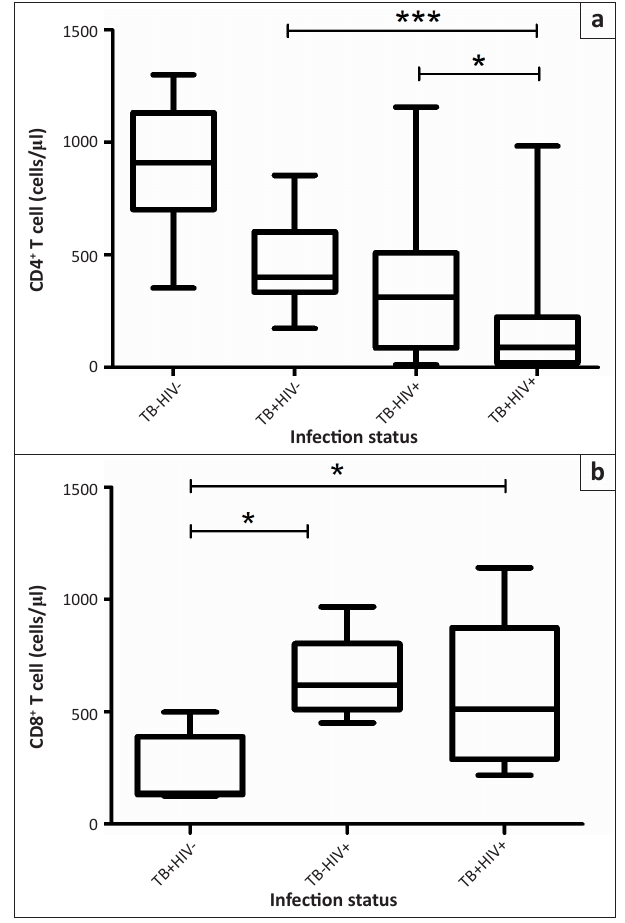
FIGURE 1: T-cell lymphocyte counts. Representative box-and-whisker plots of counts of (a) CD4 + and (b) CD8 + T-cells in TB–HIV– ( n = 10), TB+HIV– ( n = 19), TB–HIV+ ( n = 20), and TB+HIV+ ( n = 20) groups are